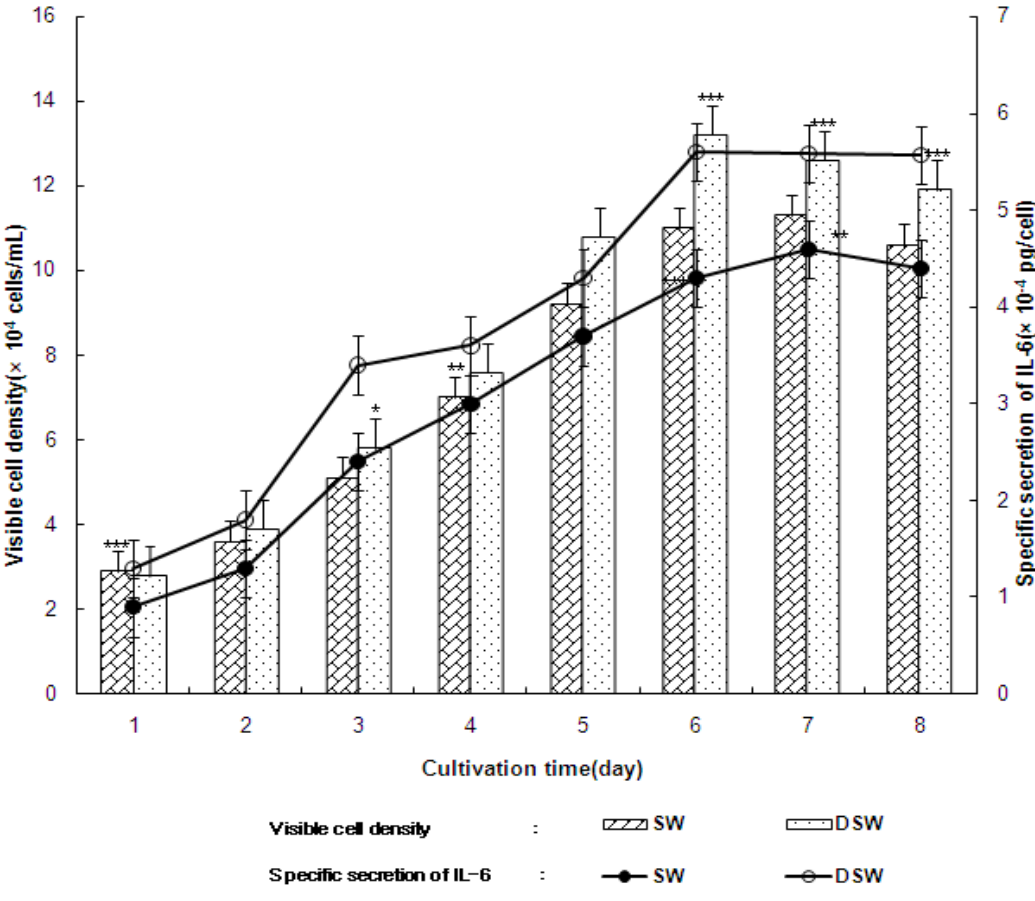
Figure 4. The growth (bar chart, percent) and secretion (line chart) of Interleukin-6 (IL-6) from human B cell after the adding 1.0 mg/mL of the water extract of S. maxima cultivated in SW and DSW. Mean ± S.D. from triplicate separated experiments are shown. Each value were compared with the control at * p < 0.01, ** p < 0.005, *** p < 0.001 by Student t -test. (SW: seawater, DSW: deep-sea water).